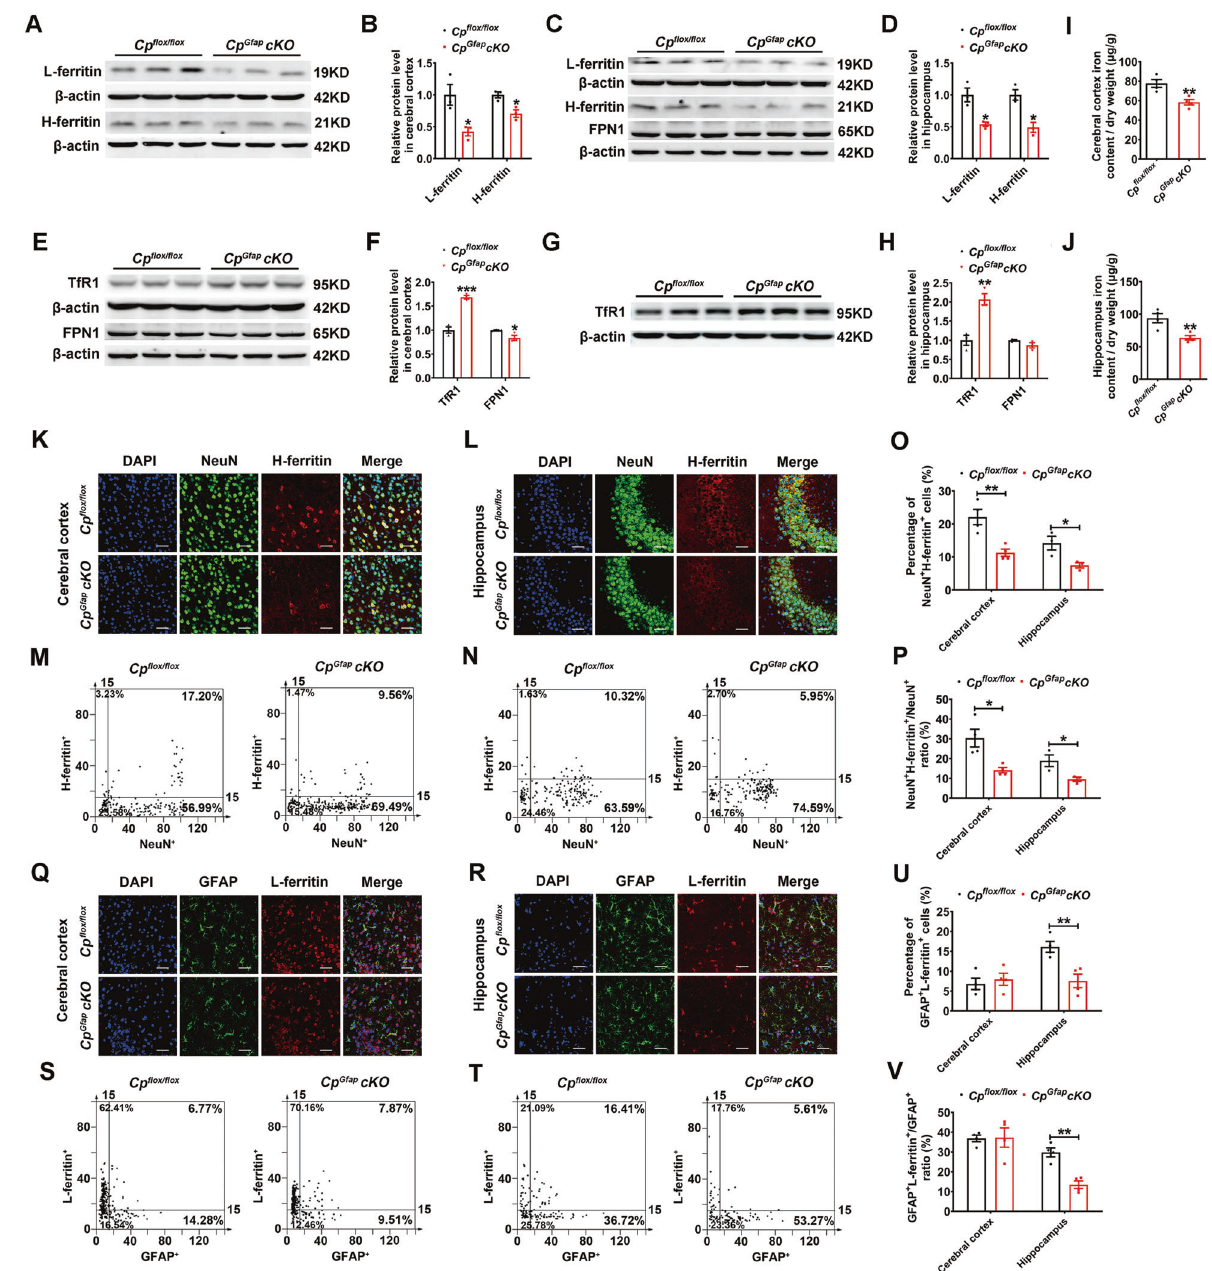
Fig. 3 Astrocytic Cp knockout decreased ferritin expression and iron contents in the cerebral cortex and hippocampus. A - D Western blot detection of L-ferritin and H-ferritin levels in the cerebral cortex ( A ) and hippocampus ( C ). Quanti fi cation of the immunostained bands (L- ferritin and H-ferritin) are presented in B and D , respectively. ( n = 3). E - H: Western blot analysis of FPN1 and TfR1 levels in the cerebral cortex ( E ) and hippocampus ( C , G) . F and H are the quanti fi cation of the light density of TfR1- and FPN1-immunostained bands. ( n = 3). I , J: Total iron content was measured by ICP-MS in the cerebral cortex ( I ) and hippocampus ( J ). ( n = 4). K - P: Double immuno fl uorescence staining of H-ferritin and NeuN in the cerebral cortex ( K ) and hippocampus ( L ) of Cp fl ox/ fl ox and Cp Gfap cKO mice. The intensity of NeuN + and H-ferritin + cells in the cerebral cortex ( M ) and hippocampus ( N ) is shown in scatter diagrams. Quanti fi cation of the percentage of the NeuN + H-ferritin + cells ( O ) and the ratio of NeuN + H-ferritin + / NeuN + ( P ) are presented on the histogram plots. ( n = 4 in the cerebral cortex and n = 3 in the hippocampus). Q - V: Double immuno fl uorescence labeling of L-ferritin and GFAP in the cerebral cortex ( Q ) and hippocampus ( R ) of Cp fl ox/ fl ox and Cp Gfap cKO mice. The intensity of GFAP + and L-ferritin + cells in the cerebral cortex ( S ) and hippocampus ( T ) is shown in scatter diagrams. Quanti fi cation of the percentage of the GFAP + L-ferritin + cells ( U ) and the ratio of GFAP + L-ferritin + / GFAP + ( V ) are presented on the histogram plots. ( n = 4). All data are shown as the mean ± SEM; * p < 0.05, ** p < 0.01, *** p < 0.001 vs. Cp fl ox/ fl ox . D). Bcl-2 (anti-apoptosis) and Bax (pro-apoptosis) proteins play (TUNEL) staining. As expected, the amounts of apoptotic cells in important roles in regulating apoptosis. From western blot these brain regions increased markedly with aging, while the analysis, we found that the ratio of Bcl-2 to Bax was decreased number of apoptotic cells was signi fi cantly lower in the 18 M in both the cerebral cortex and hippocampus with aging, but Cp Gfap cKO mice compared with the 18 M Cp fl ox/ fl ox mice (Fig. 7A, C,